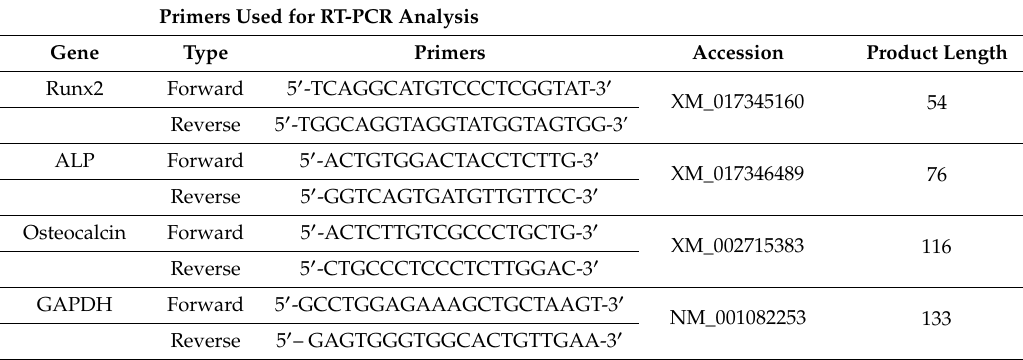
Table 1. Primers for RT-PCR analysis of osteogenic di ff erentiated